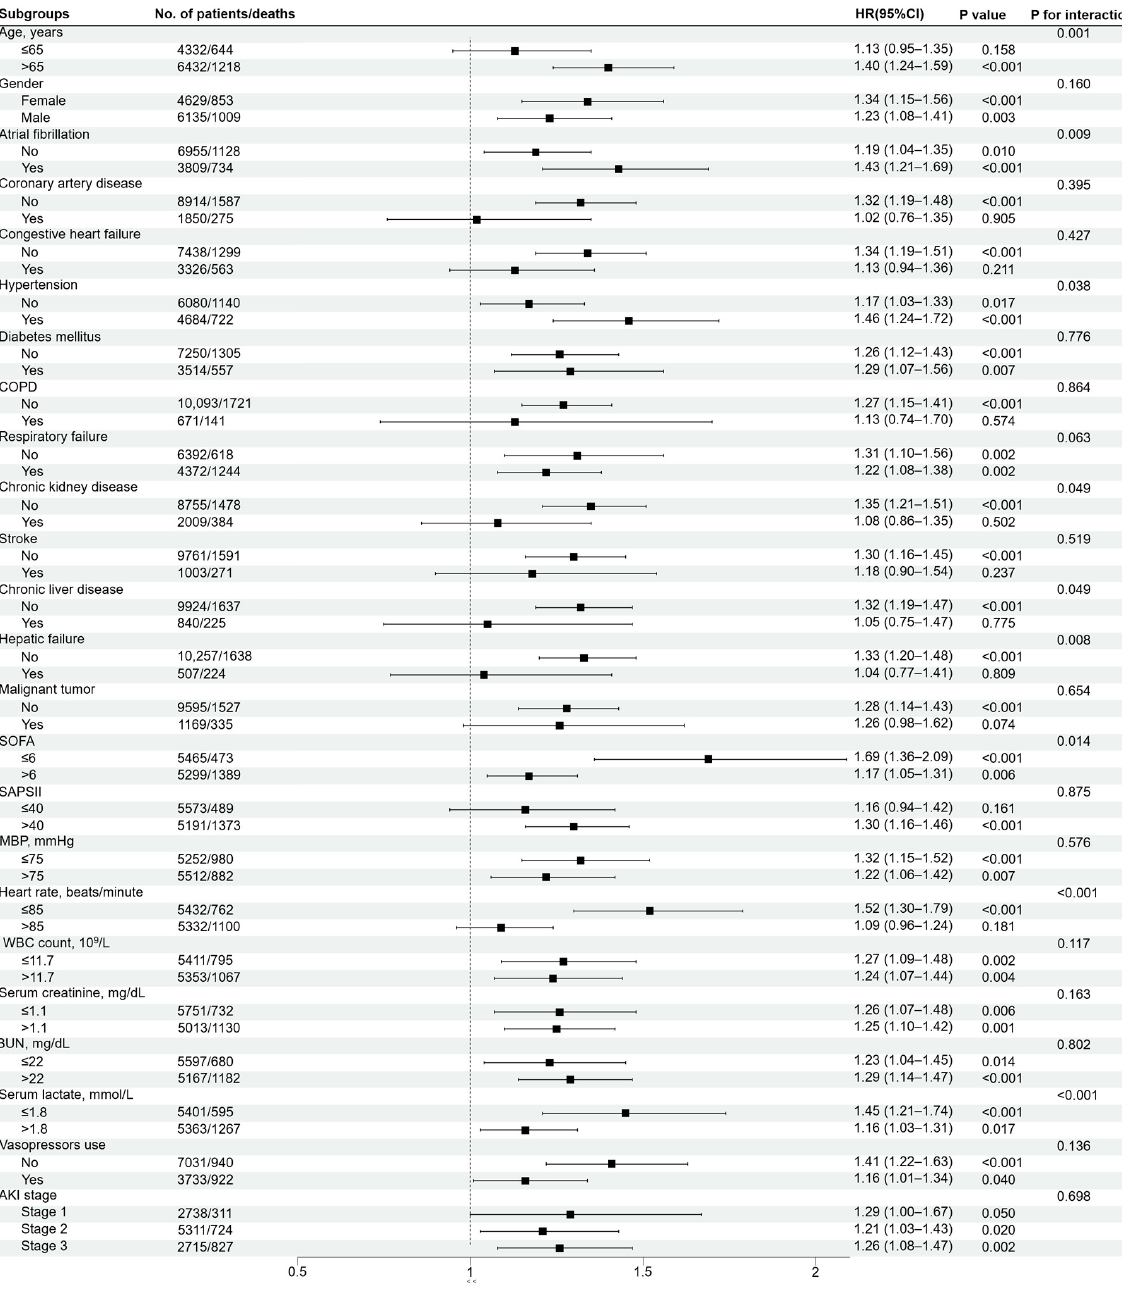
Figure 3. Forest plot of SII for in-hospital mortality in prespecified subgroups. Multivariable Cox regression analysis in subgroups adjusted the same covariates as for Model 3 in Table 2. SII, Systemic immune-inflammation index; COPD, Chronic obstructive pulmonary disease; MBP, Mean blood pressure; WBC, White blood cell; SCr, Serum creatine; BUN, Blood urea nitrogen; SOFA, Sequential organ failure assessment; SAPSII, Simplified acute physiology score II; AKI, Acute kidney